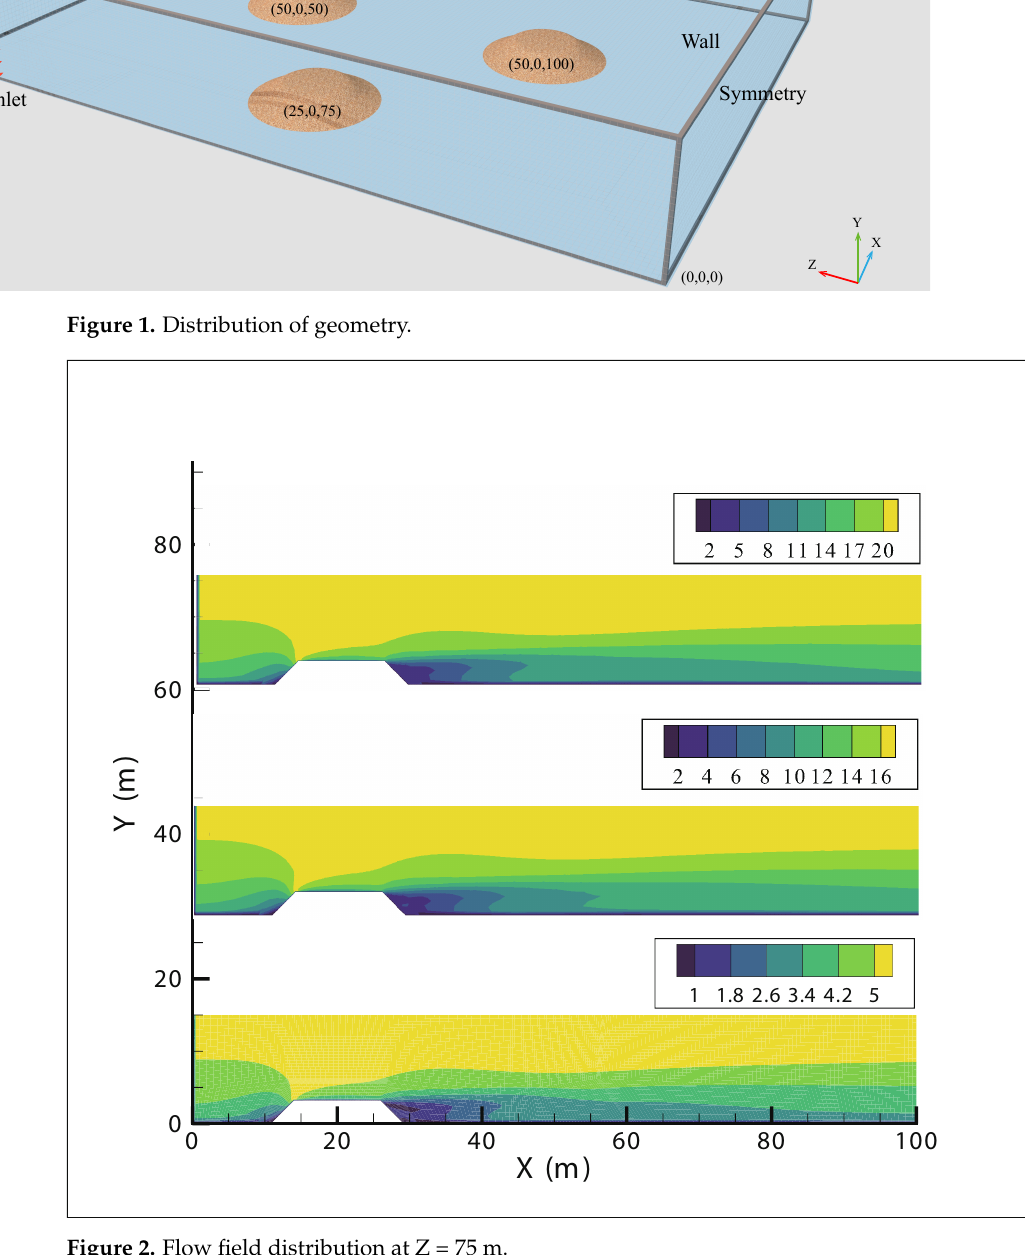
Figure 2. Flow field distribution at Z = 75